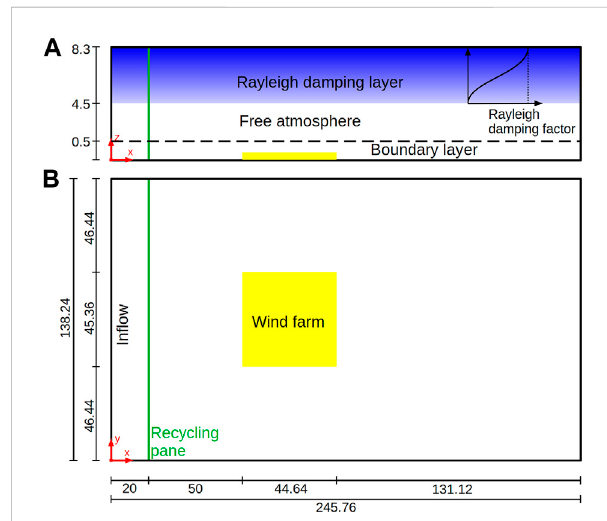
FIGURE 1 (A) Side view of the domain layout. Inside the Rayleigh damping layer the damping factor increases according to the sin 2 -function in Eq. 4. (B) Plan view of the domain layout. Dimensions in km.